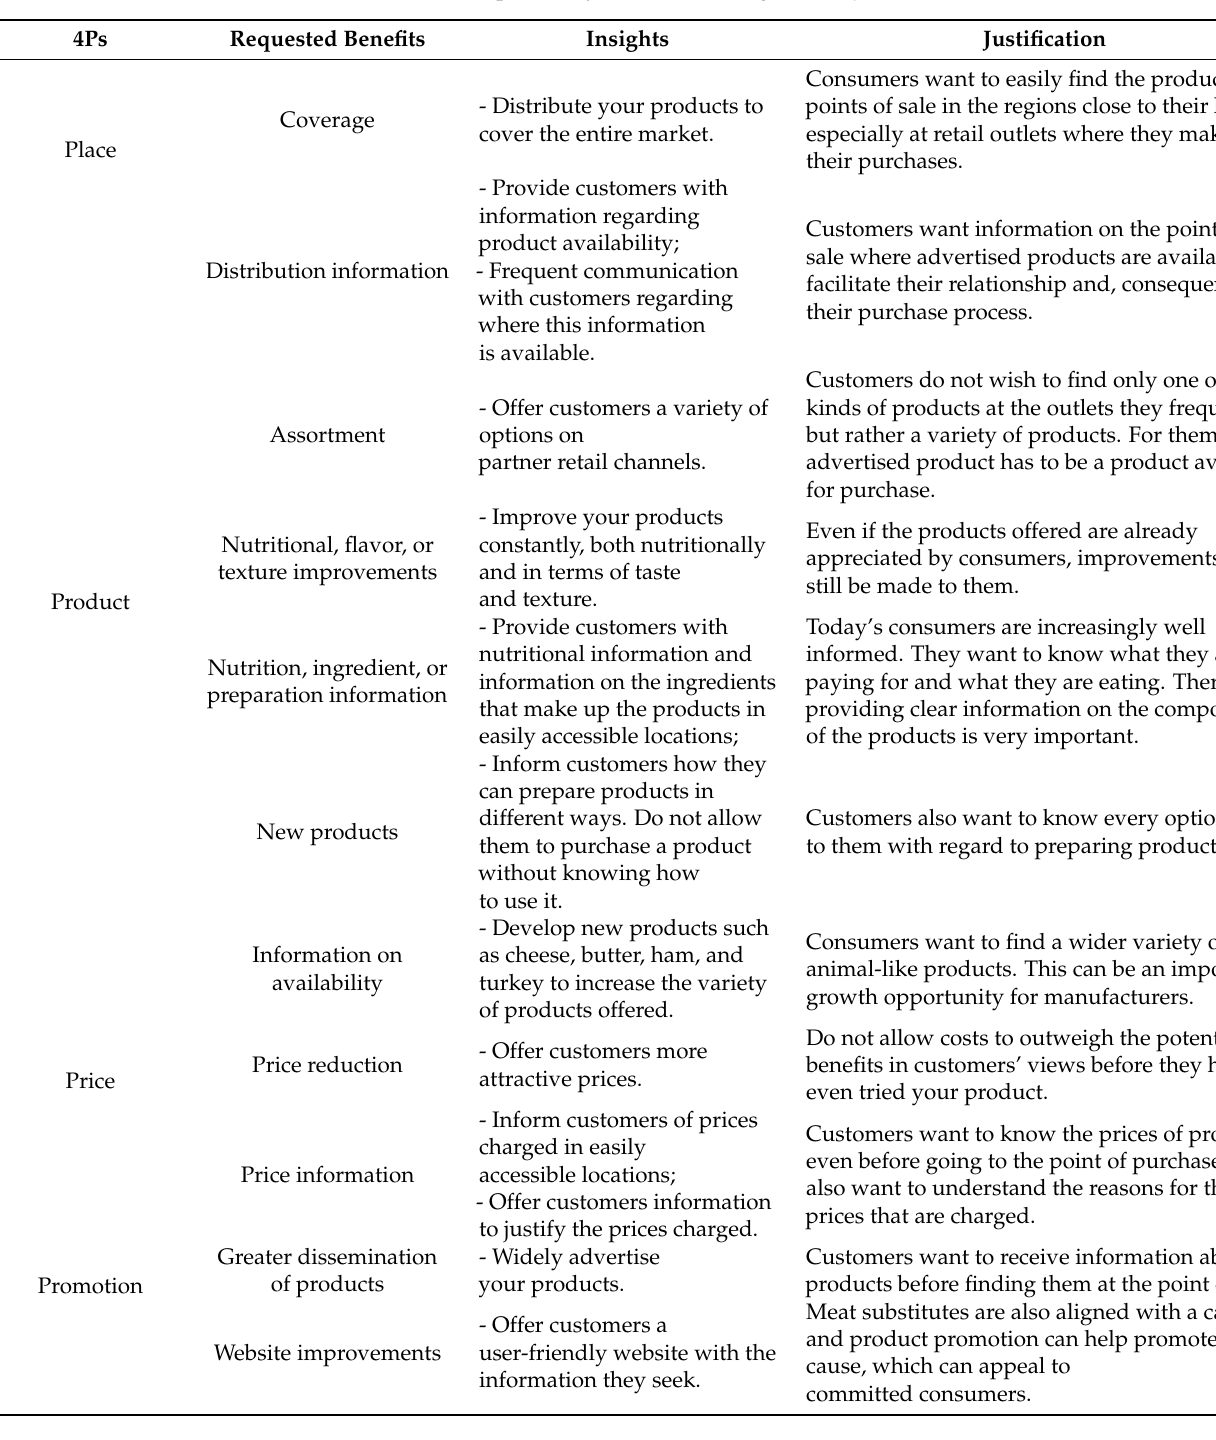
Table 8. Benefits requested by consumers, insights, and